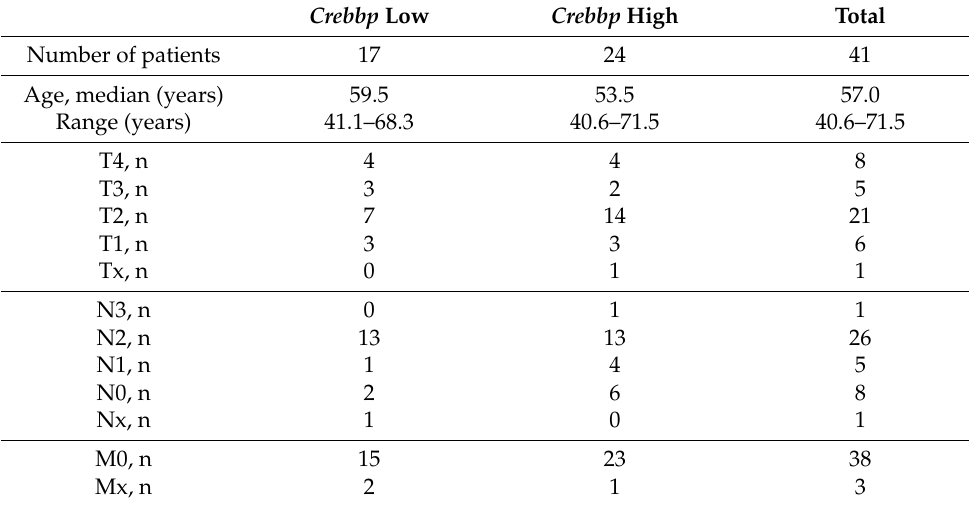
Table 1. TCGA cohort patient characteristics and distribution into the two groups post-stratification based on Crebbp expression. Crebbp ; Creb-binding protein, T; T-stage, N; N-stage, M; M-stage, Tx/Nx/Mx; unknown stage.